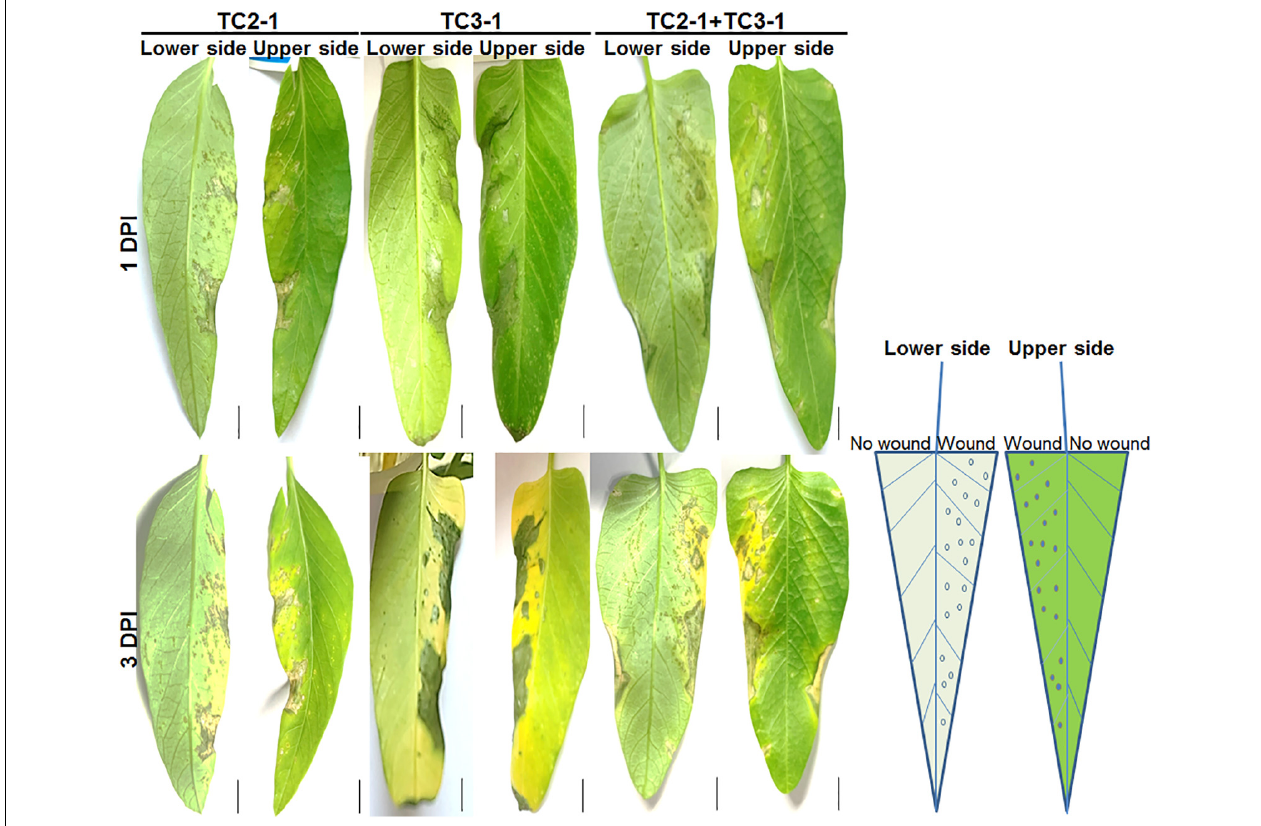
FIGURE 4 | Co-inoculation of TC2-1 and TC3-1 on water spinach leaves. Sterile toothbrushes were used to gently brush on the right half lower side of blades to make micro wounds, 100 µ l of bacterial cultures (grown in LB medium until OD 600 = 1.5) of TC2-1, TC3-1, or TC2-1 + TC3-1 mixture were evenly spread onto the whole lower side of each blade. Photos were taken after 1 and 3 DPI (days post inoculation), respectively. Scale bar = 1 cm.